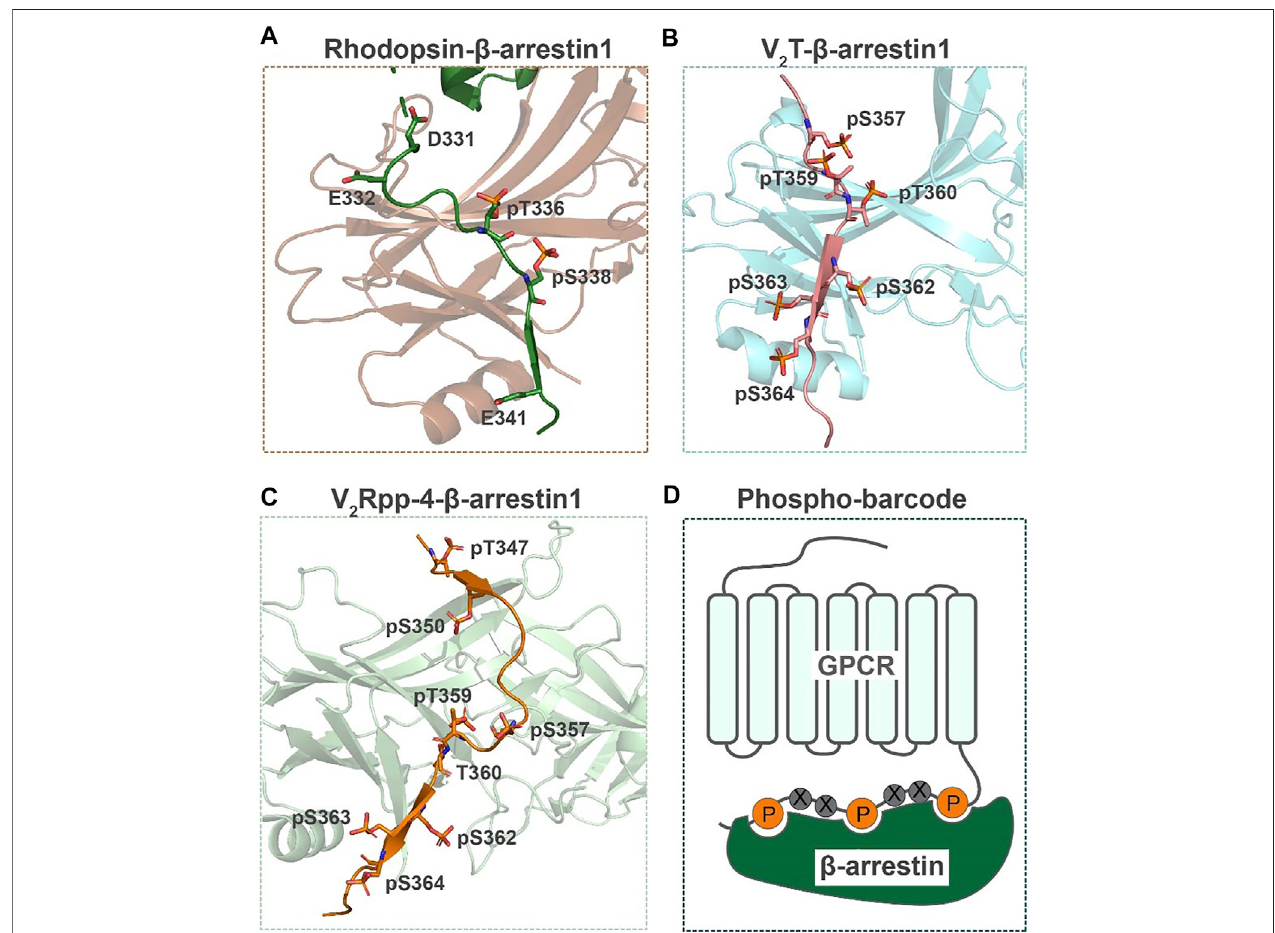
FIGURE3| GPCRphosphorylationsitespresentincrystalorcryo-EMstructures. (A) ThephosphorylatedrhodopsinCterminus(green)interactingwith β -arrestin1 (brown) in the crystal structure (Zhou et al., 2017). (B) Phosphorylated residues on V 2 T (pink) interacting with β -arrestin1 (light blue) in the cryo-EM structure (Nguyen et al., 2019). (C) Crystal structureof β -arrestin1 (light green) in complex with aV 2 Rphosphopeptide (orange) (He et al., 2021). (D) Amodel oftheGPCRphosphorylation code in a pattern of P x(x) P xx P for β -arrestin recruitment (Zhou et al., 2017).